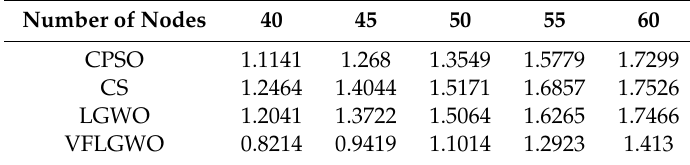
Table 7. Uniformity with different number of sensor nodes.